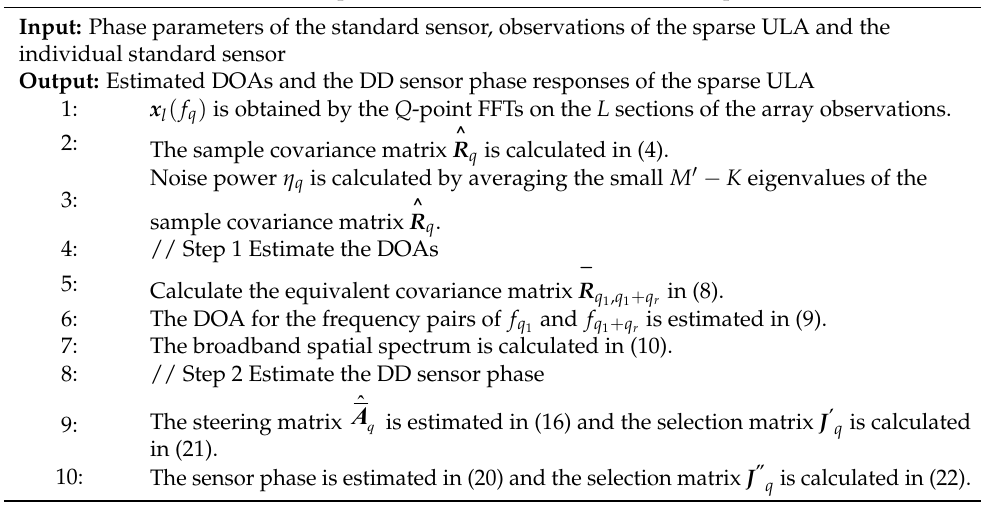
Table 1. Algorithmic steps in the proposed method. Algorithm: Self-calibration for sparse ULAs with unknown DD sensor phase Input: Phase parameters of the standard sensor, observations of the sparse ULA and the individual standard